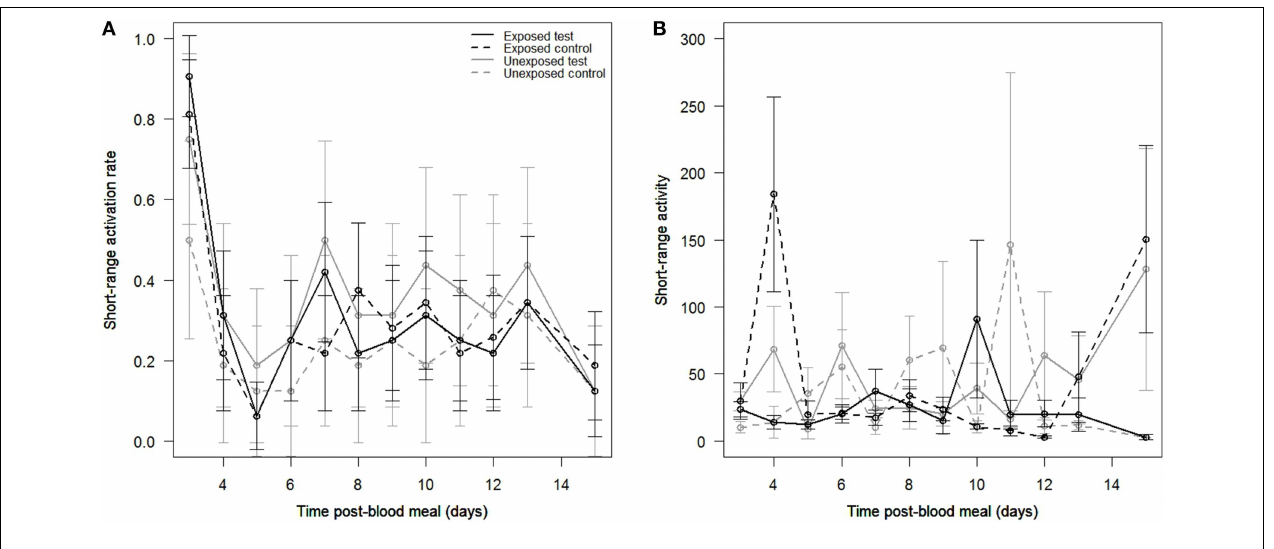
FIGURE 4 | Mosquito short-range behavioral responses (assay I). Effects of time post-blood meal, parasite exposure, and odor stimuli on (A) the short-range activation of mosquito females, expressed as the proportion of mosquitoes that crossed at least